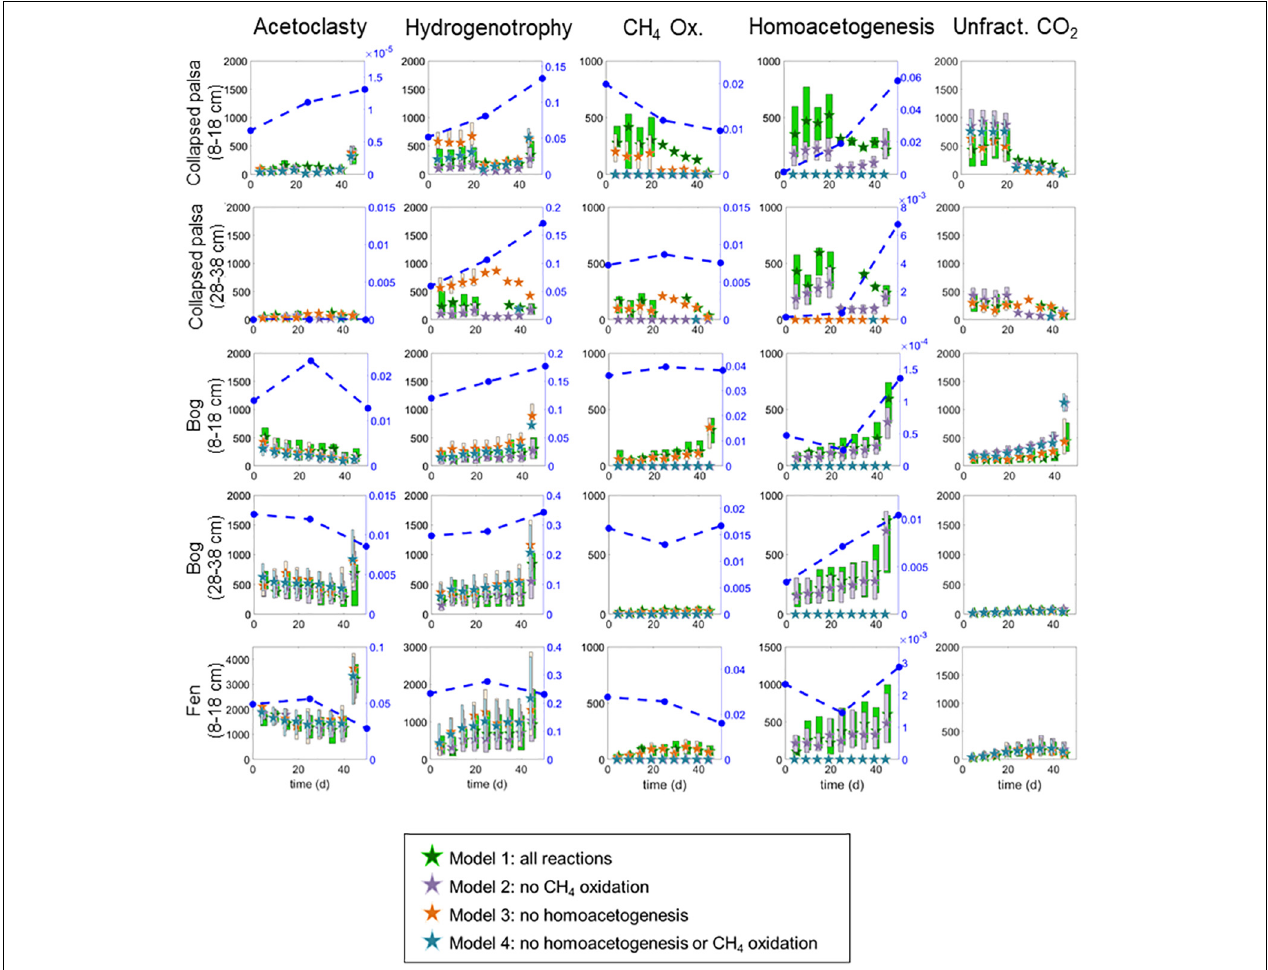
FIGURE 4 | Rate results from the four variants of the reaction network model. All rates are in µ mol month - 1 . Stars are medians and boxes vertically outline interquartile ranges of the posterior likelihoods. Box widths are staggered so that overlapping ranges can be visually distinguished. Blue circles with dashed lines indicate abundances of microorganisms thought to perform the relevant reaction (i.e., acetoclasts, hydrogenotrophs, or genus-level homoacetogens) plotted against the secondary right-hand axis. Aerobic methane oxidizers are also included on the CH 4 Ox. graph for comparison. Note that the scale on the fen acetoclasty, hydrogenotrophy, and homoacetogenesis results differ from other habitats due to the higher overall rates in this